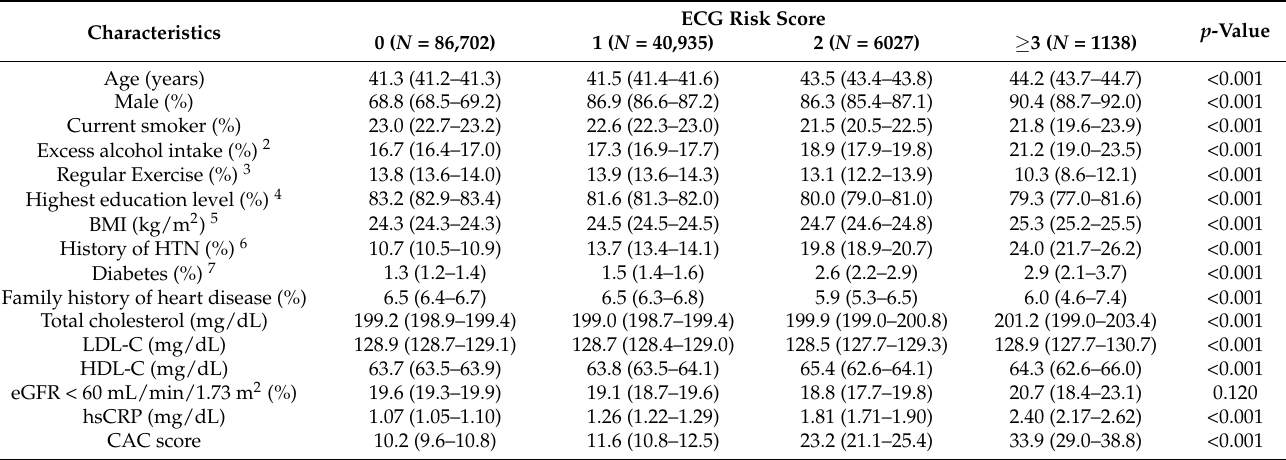
Table 1. Estimated 1 mean value (95%) and adjusted 1 proportion (95% CI) of the baseline characteris- tics of the study population ( n = 134,802).